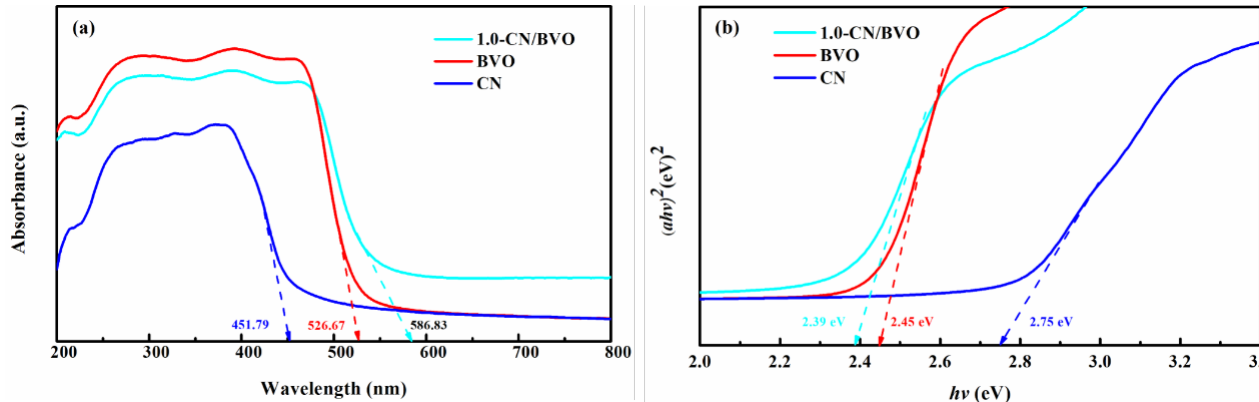
Figure 4. ( a ) UV – Vis spectrum and ( b ) band gaps ( E g ) of pristine CN, BVO, and 1.0-CN/BVO composites. Figure 4. ( a ) UV–Vis spectrum and ( b ) band gaps (E g ) of pristine CN, BVO, and 1.0-CN/BVO